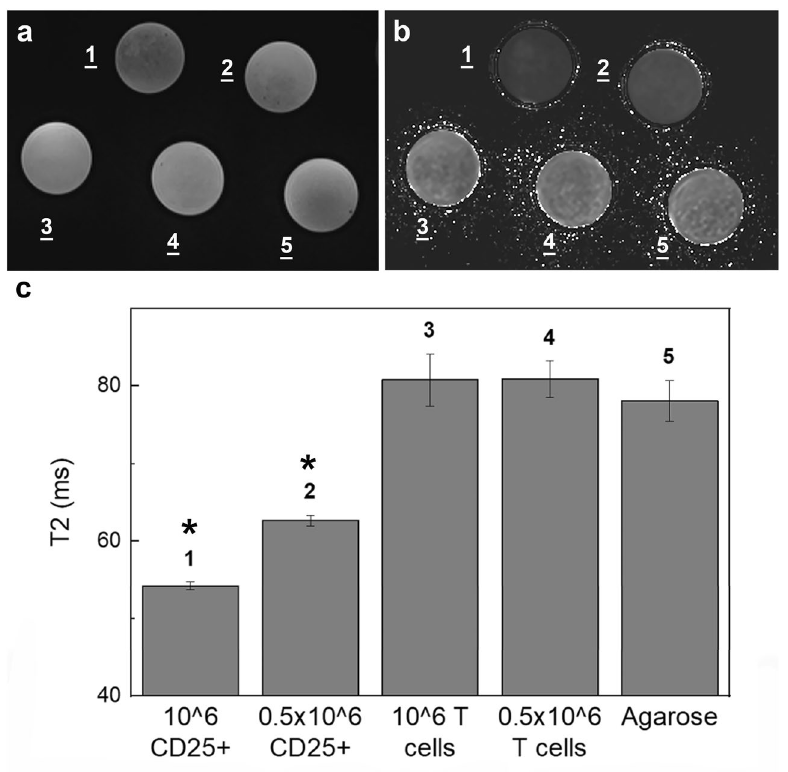
Figure 6. Magnetic resonance signal effects of CD25 microbead-labeled Tregs. T2-weighted magnetic resonance images ( a ) and corresponding T2 relaxation time maps ( b ) of agarose gels containing CD25 microbead-labeled Tregs (1–2) show marked signal reduction compared to unlabeled T cells (3–4) and agarose (5) controls. Quantitative analysis of the T2 relaxation times ( c ) confirms significant T2 shortening in CD25- microbead labeled cells. T2 of half million Tregs is 22% lower than the T2 of unlabeled T cells and agarose alone (* P = 0.0001 and 0.0006 respectively). T2 is further shortened (33%) in one million labeled Treg samples (* P = 0.001 compared to half million Treg sample). Data are presented as mean ± standard